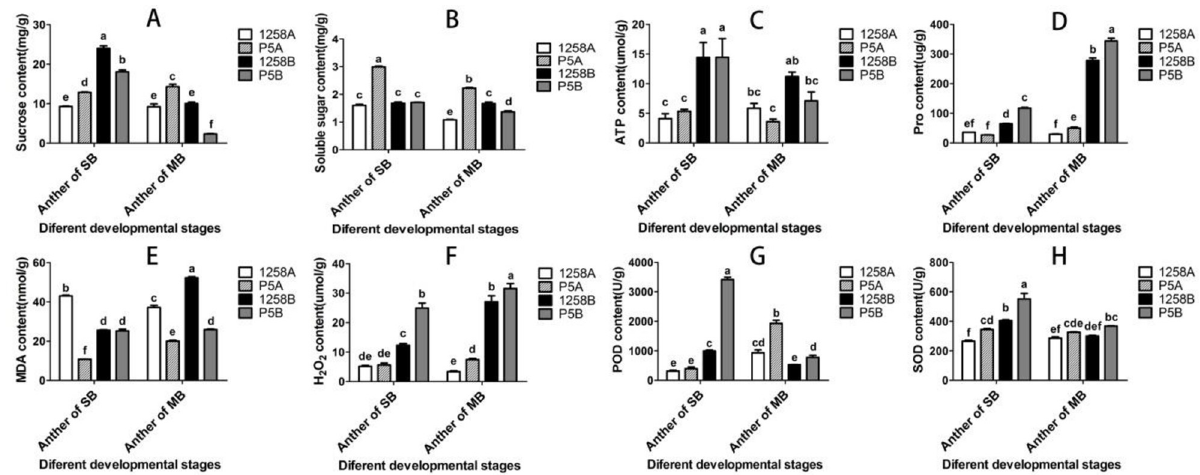
Fig 3. Physiological and biochemical indexes for 1258A and P5A anthers at different periods of development. A-F: sucrose, soluble sugar, ATP, Pro, MDA, H 2 O 2 , POD and SOD content. Duncan’ multiple range tests was used to analyze the data. The lower case letters in the figure represent the comparison at the level of 0.05. The same letter indicates that the difference is not significant, and the different letters indicate that the difference is